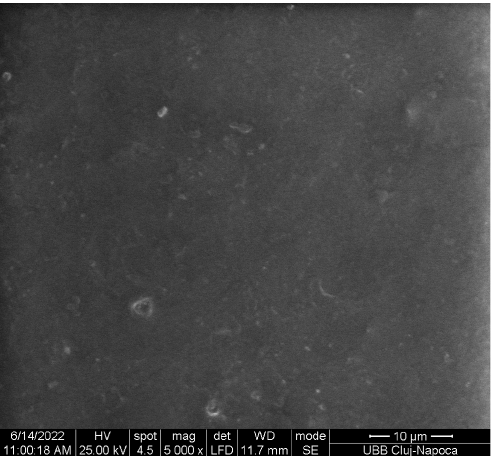
Figure 13. SEM image × 5000 magnification on the PLA-Cu1 sample surface.